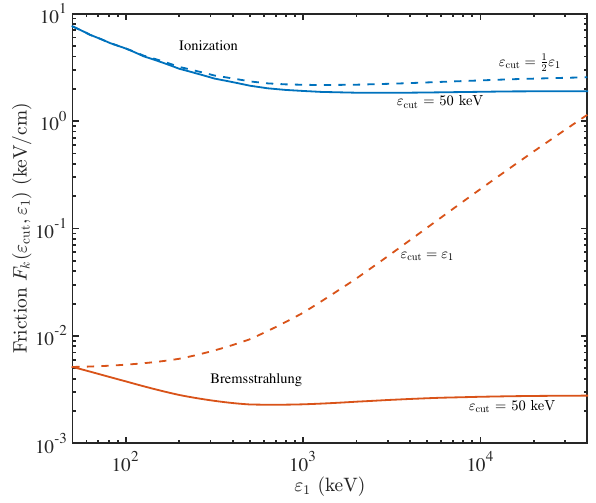
Figure 1. Friction F k (ε cut ,ε 1 ) for electrons per interaction (bremsstrahlung in red and ionization in blue) for two different low energy cutoffs, ε cut = 50keV (solid line) and ε cut = ε max (dashed line). The resulting friction is the sum of the two contributions, which in the energy regime of HEAP is dominated by the ionization (please note the log scale). The data are from Cullen et al. (1997) and Perkins et al. (1991) for an air density of 1 . 293 × 10 − 3 gcm − 3 corresponding to 1bar and 273K as used in this